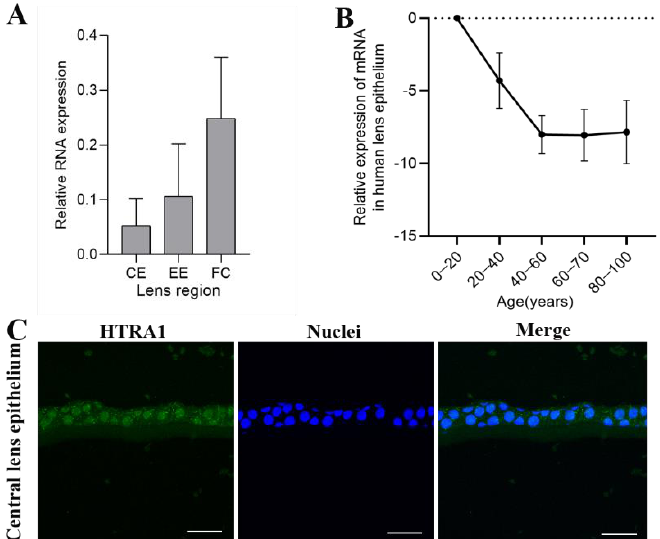
Figure 2. HTRA1 expression levels in normal human lenses at different layers and for different age groups. ( A ) The mRNA levels of HTRA1 expressed in central lens epithelial cells, equatorial epithelial cells and fibre cells in normal human lenses. ( B ) The mRNA levels of HTRA1 expressed in different age groups. ( C ) Immunofluorescence images of HTRA1 staining in HLECs ( n = 3). Scale bar: 10 μm.